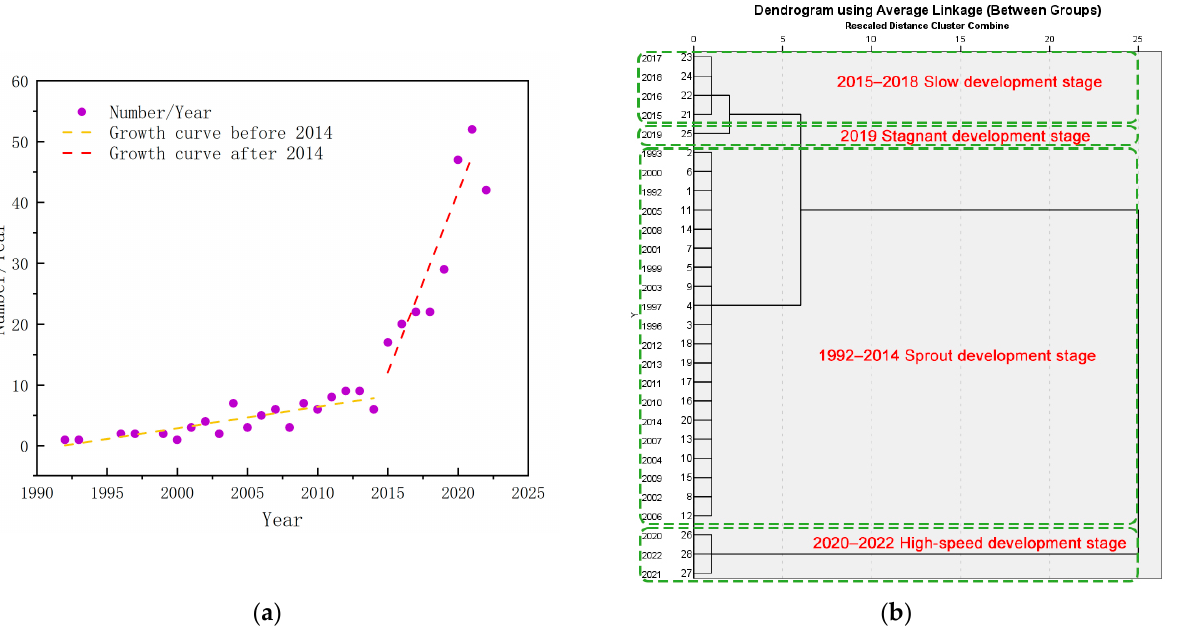
Figure 3. ( a ) Number of annual publications on the direction of straw building materials’ energy e ffi ciency; ( b ) the stages of research and development of straw building materials’ energy e ffi ciency from 1992 to